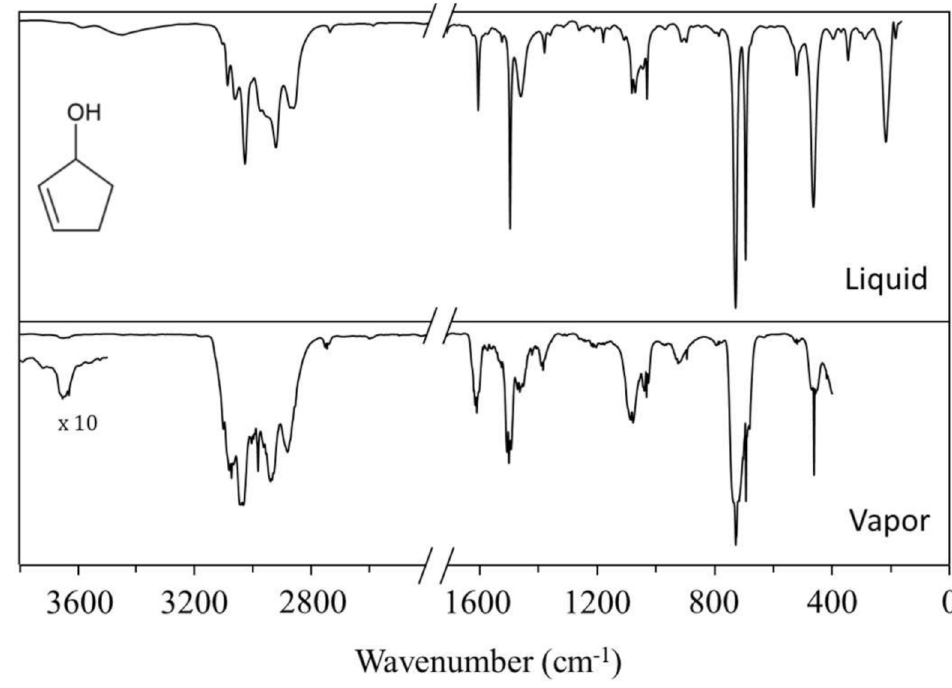
Figure 3. Observed infrared spectra of 2CPOL. Table 3. Observed and calculated frequency differences for selected vibrations conformer A of 2CPOL compared to those observed for other five-membered ring